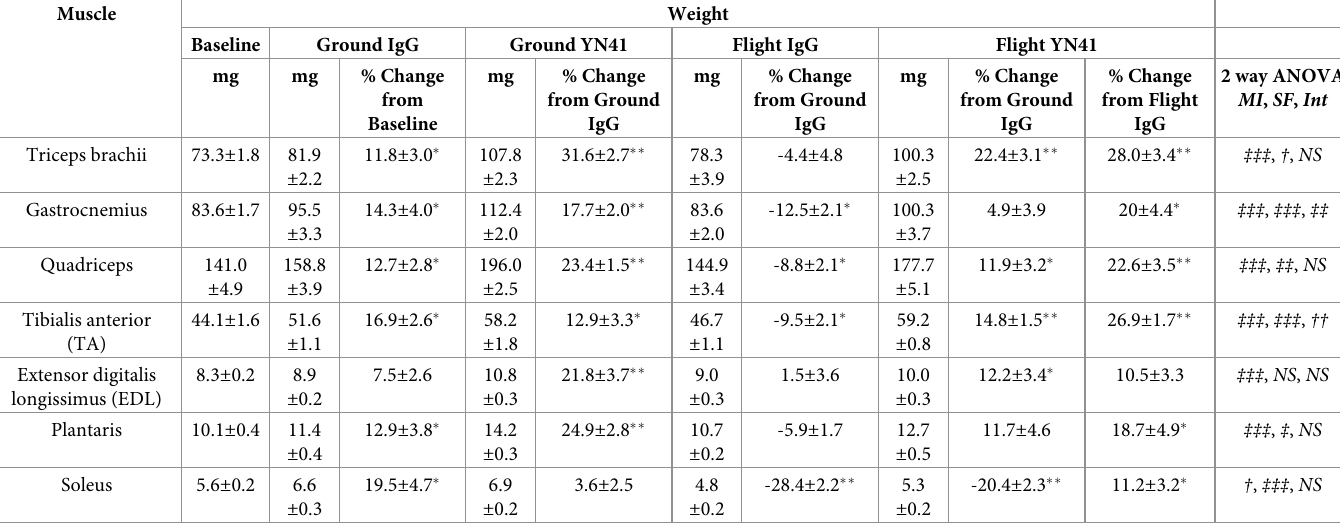
Table 1. Effect of myostatin inhibition on individual muscle weights under conditions of microgravity. Muscle